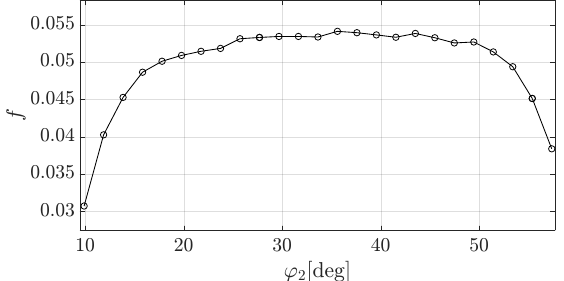
Figure 7. Coefficient of friction ( f ) over a mesh cycle.